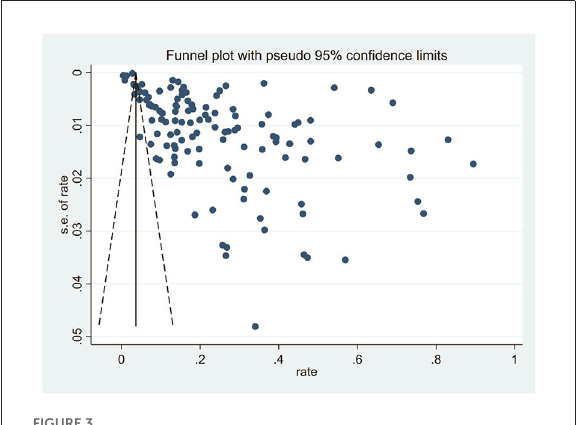
FIGURE3 Publication bias funnel plot.